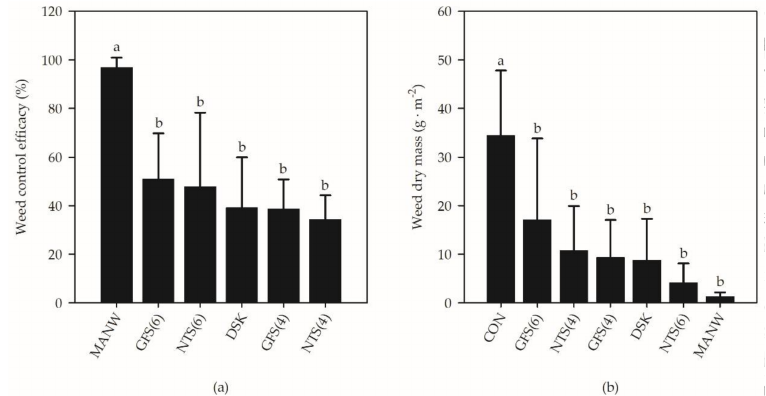
Figure 6. ( a ) Mean weed control efficacy in spring oats; ( b ) weed dry mass in spring oats recorded at Kleinhohenheim in 2017. Means with the same letter are not statistically different according to Duncan’s multiple range test at α ≤ 0.05. CON = untreated control, MANW = manual weeding, GFS(4) = goosefoot sweeps 4 km · h − 1 , GFS(6) = goosefoot sweeps 6 km · h − 1 , NTS(4) = no-till sweeps 4 km · h − 1 , NTS(6) = no-till sweeps 6 km · h − 1 , DSK = down-cut side knife 4 km · h − 1